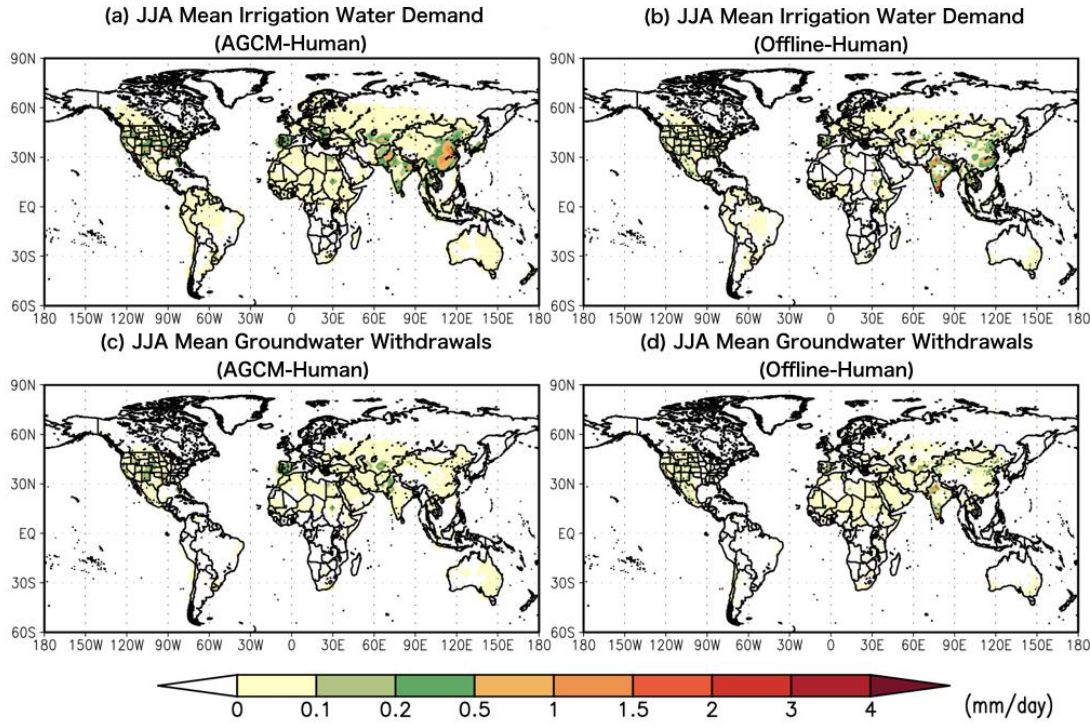
Figure 1. Spatial distribution of the irrigation water demand and groundwater withdrawals from AGCM–Human ( a and c ) and Offline–Human ( b and d ) simulations, respectively. Results are shown in mm/day and are averaged over the boreal summer (June–August: JJA) during the years 1998 to 2010. Table 2. Comparison of AGCM–Human simulated total irrigation water demand (actual use) and withdrawal (water withdrawn from source) with various previous estimates, including reported statistics and offline model results.